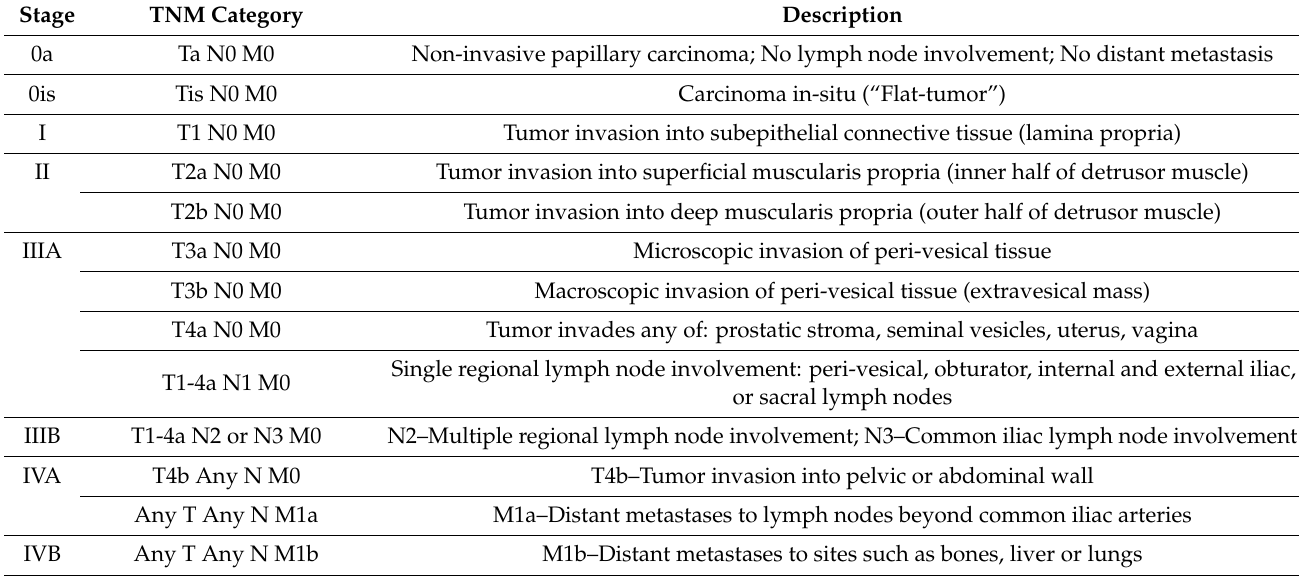
Table 6. AJCC staging of urinary bladder malignancy—8th edition